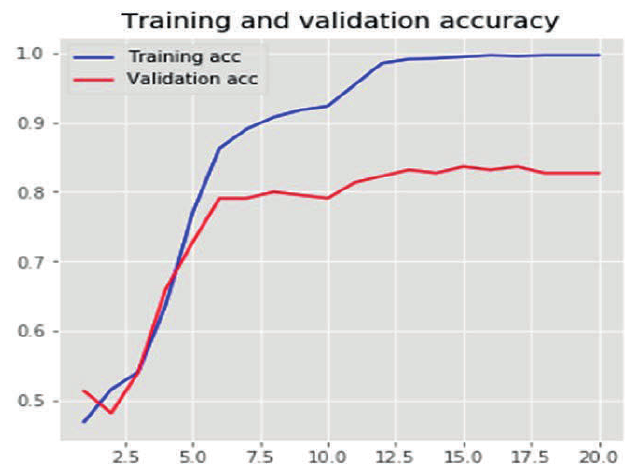
Fig. 7. Training and validation accuracy for the sentiment classification phase.